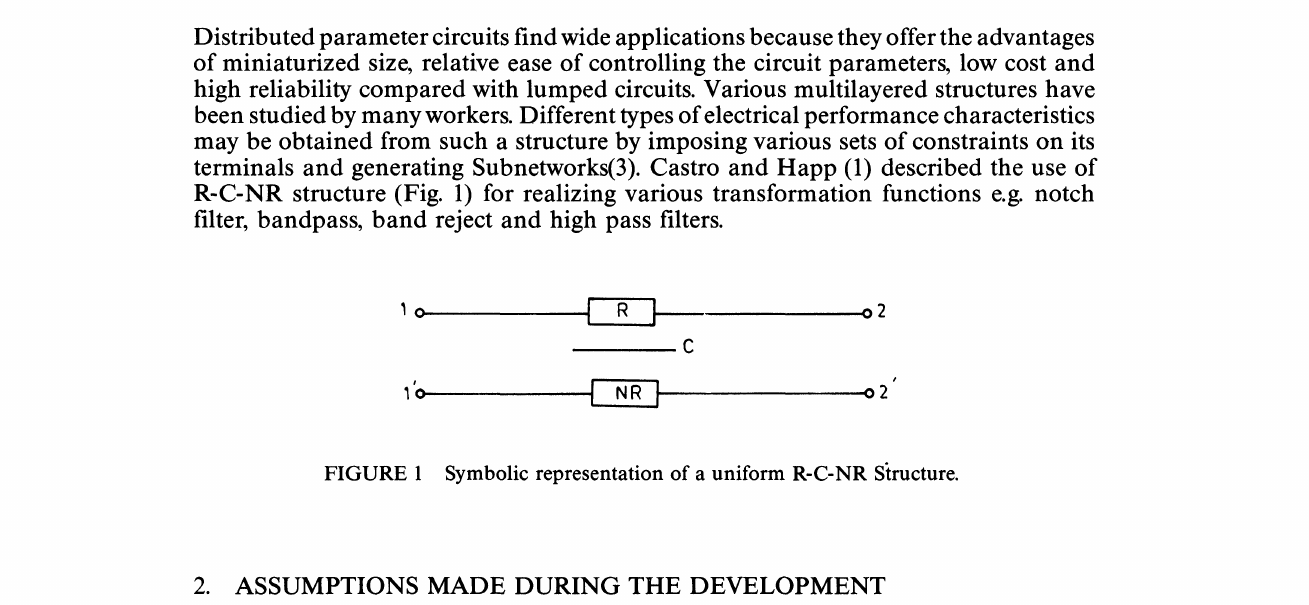
FIGURE Symbolic representation of a uniform R-C-NR